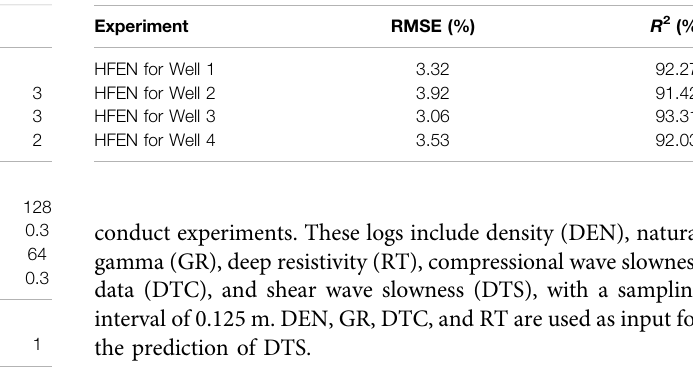
TABLE 1 | Neural network parameters. TABLE 2 | Comparison of HFEN-predicted results to